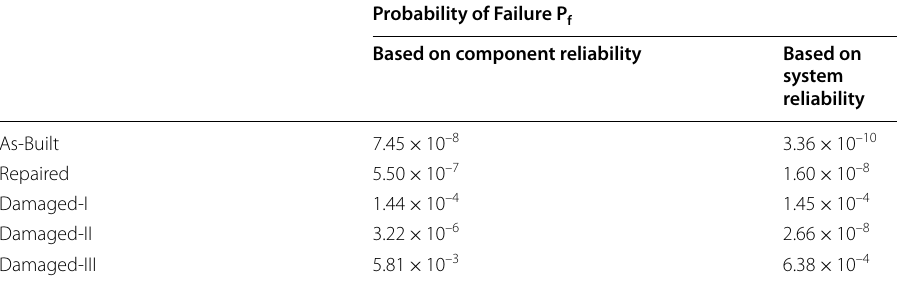
Table 6 Probability of failure based on critical girder component reliability versus probability of failure based on system